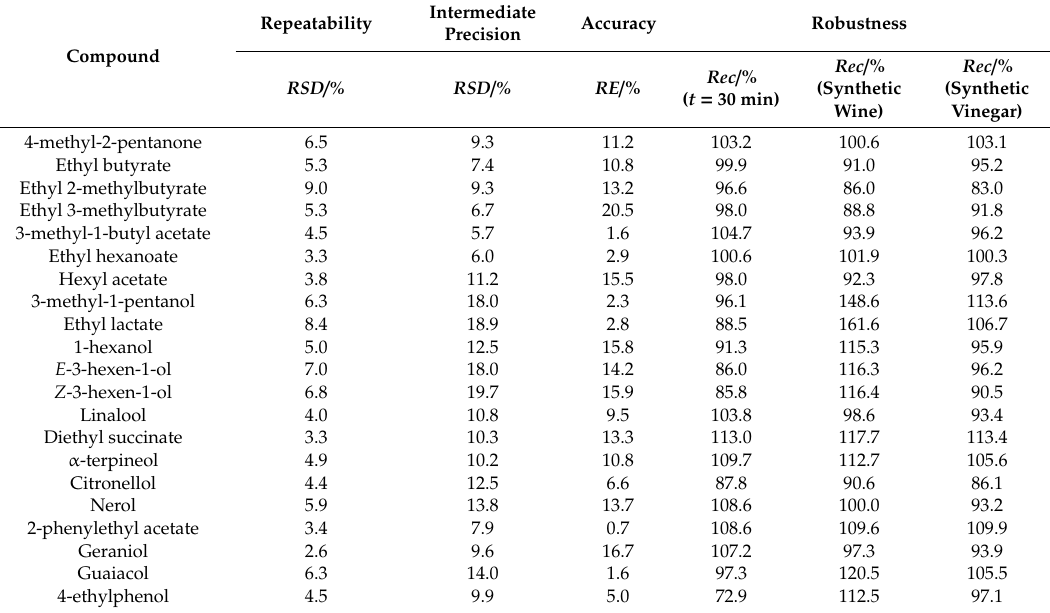
Table 2. Values obtained for evaluation of precision, measured as relative standard deviation ( RSD ), accuracy, expressed as relative error ( RE ), and robustness, quantified by compound recovery ( Rec